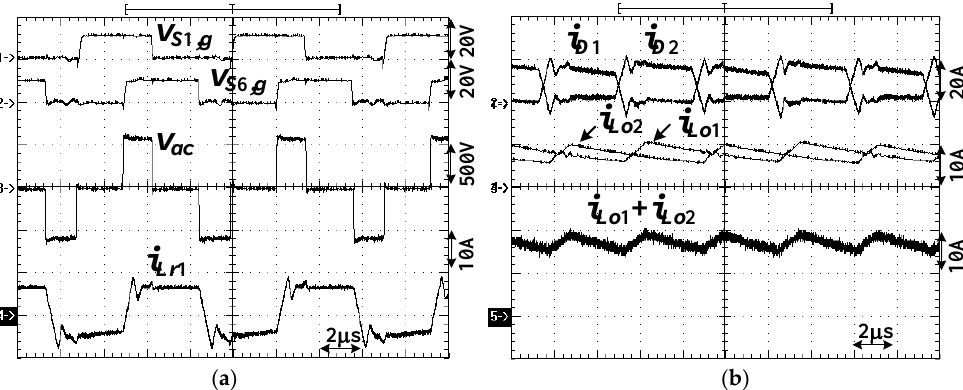
Figure 12. Test waveforms at V in = 600 V and P o = 800 W: ( a ) primary-side waveforms v S 1 ,g , v S 5 ,g , v ac , and i Lr 1 ; ( b ) secondary-side waveforms i D 1 , i D 2 , i Lo 1 , i Lo 2 , and i Lo 1 + i Lo 2 .